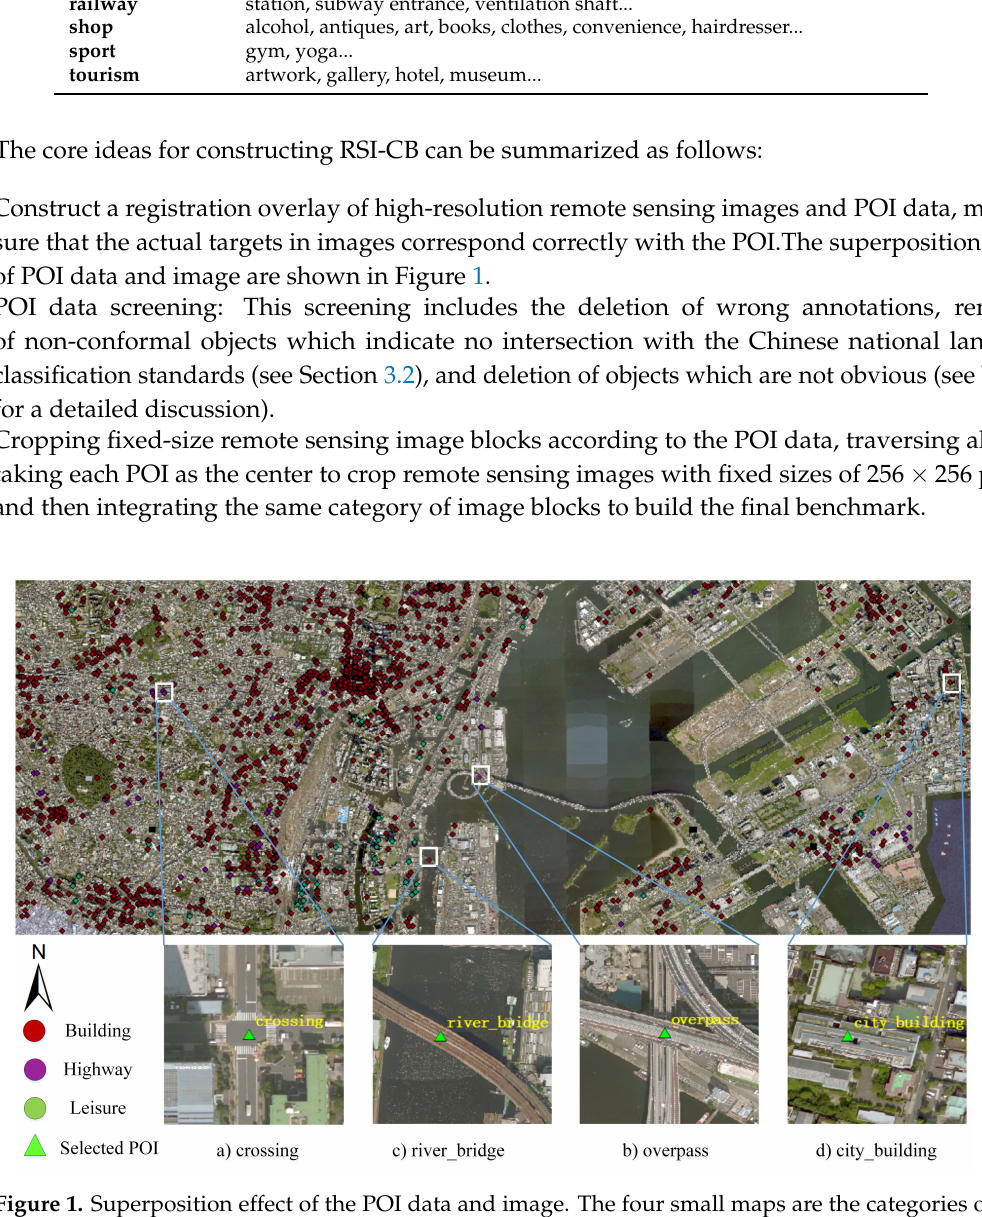
Figure 1. Superposition effect of the POI data and image. The four small maps are the categories of crossing, overpass, river_bridge, and city_building, respectively, which are used as the center points for cropping remote sensing images (the large image is part of the Shanghai area, and its spatial resolution is sub